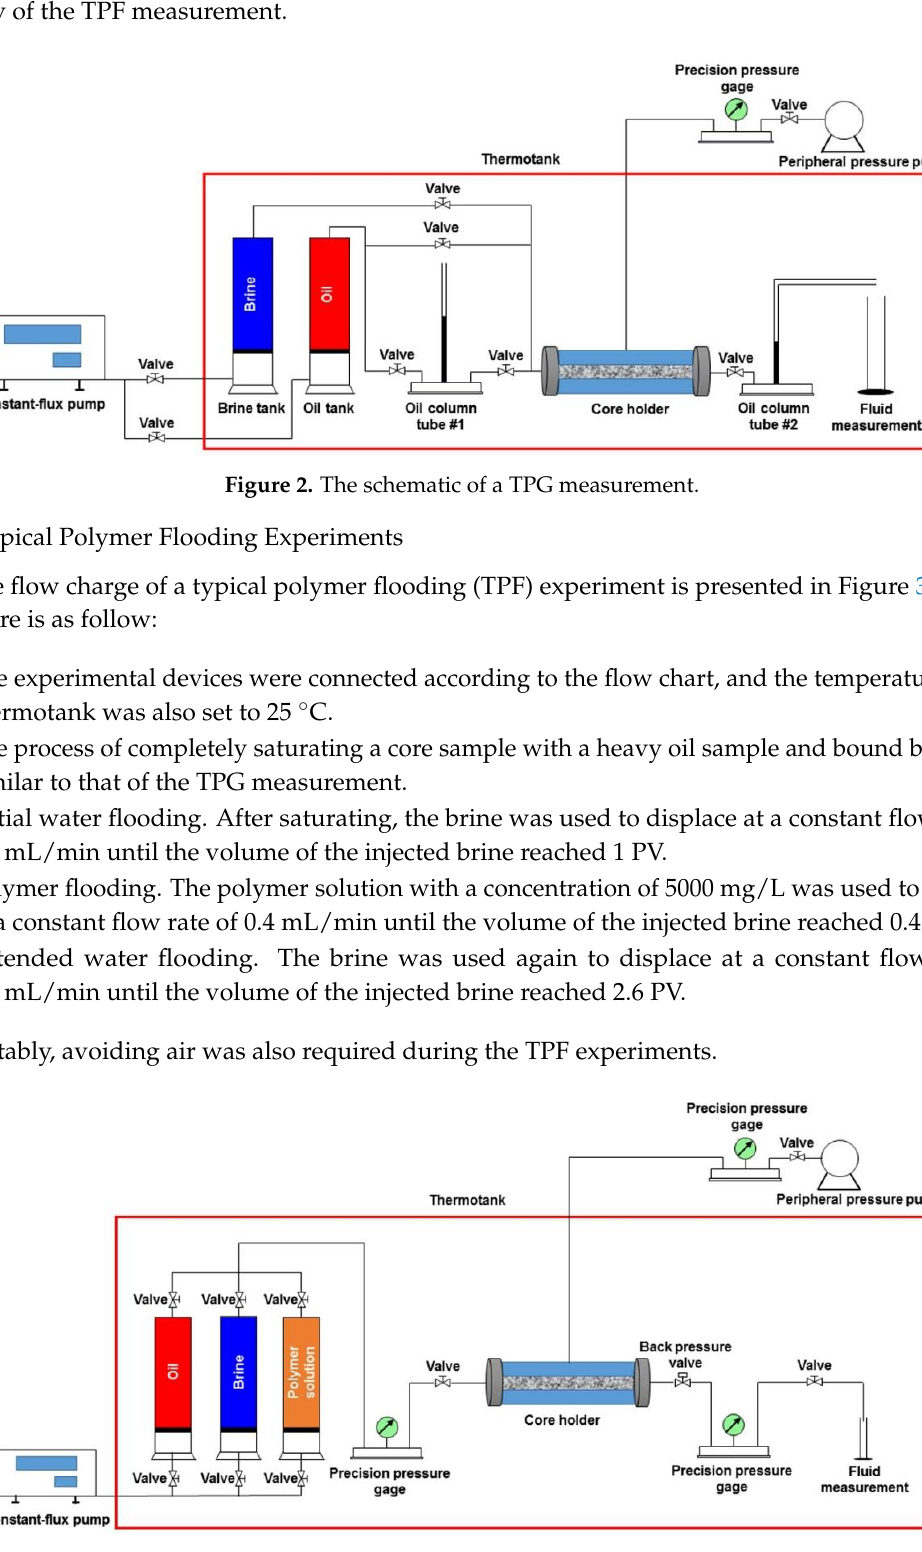
Figure 3. The schematic of a typical polymer flooding experiment.